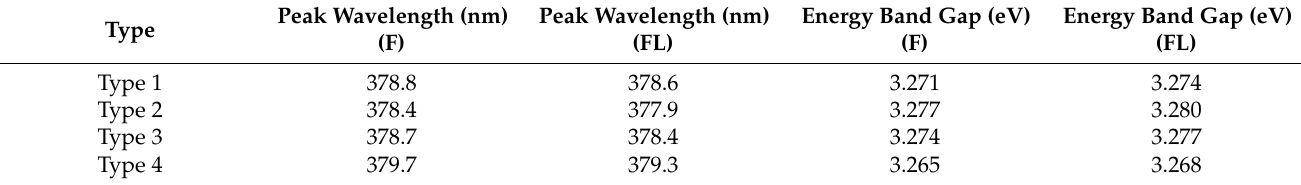
Table 3. Peak wavelength and energy band gap of (In, Ga) co-doped multilayered thin films with 2 different annealing processes; F: electrical furnace annealing, FL: electrical furnace + carbon-dioxide laser